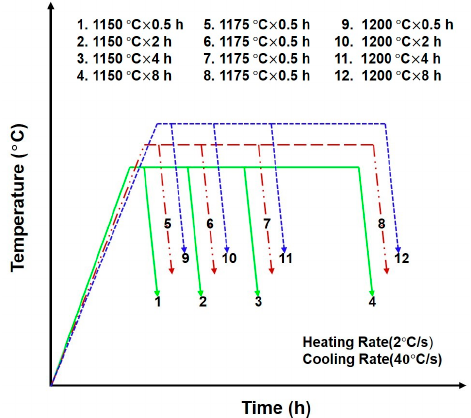
Figure 1. Schematic of solution heat treatment tests for the P/M FGH97 superalloy.